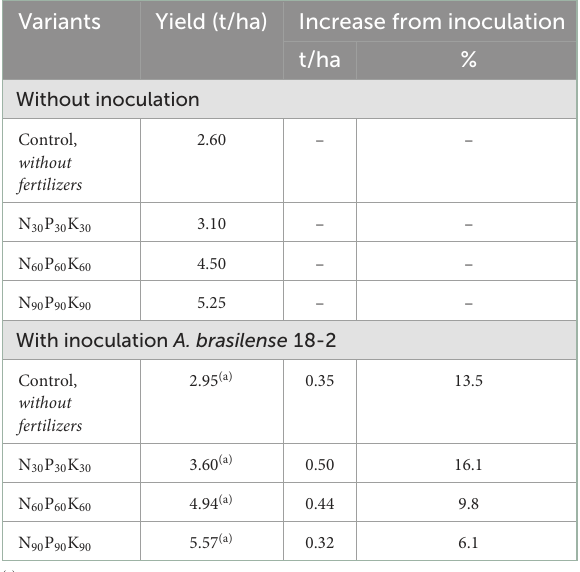
Without fertilizers